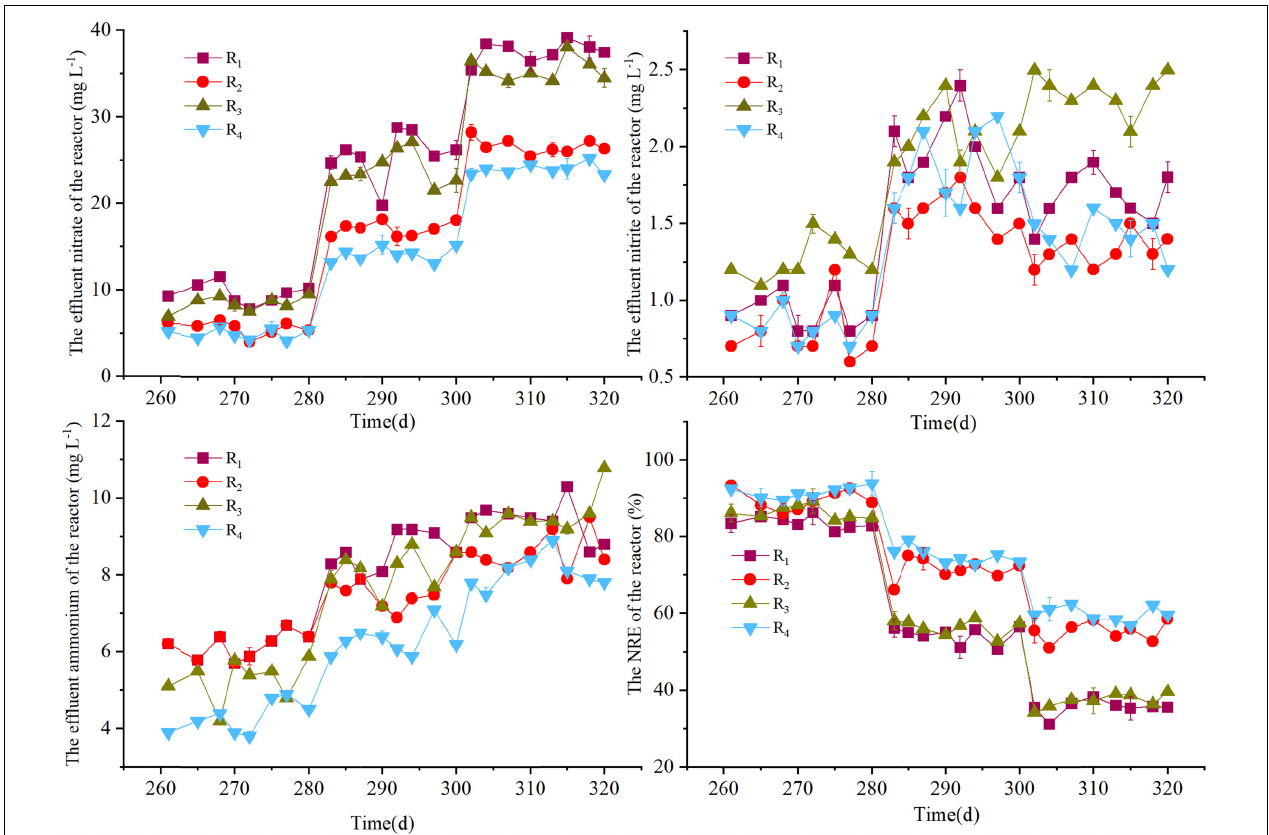
FIGURE 4 | Variations in nitrate, nitrite, ammonium, and NRE in period 8 of the R 1 –R 4